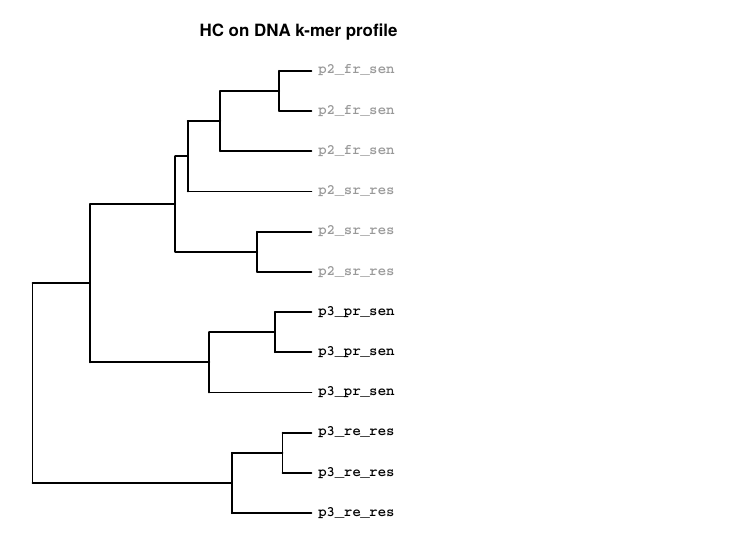
Figure 2. Clustering according to experimental groups. KBM-7 chronic myelogenous leukaemia cells with and without knockout of gene NUDT2 were analysed using RNAseq. The sample data was downloaded from ArrayExpress (accession E-MTAB-4104, only the first of the Fastq files from paired end sequencing (*_1.fastq.gz) are included).